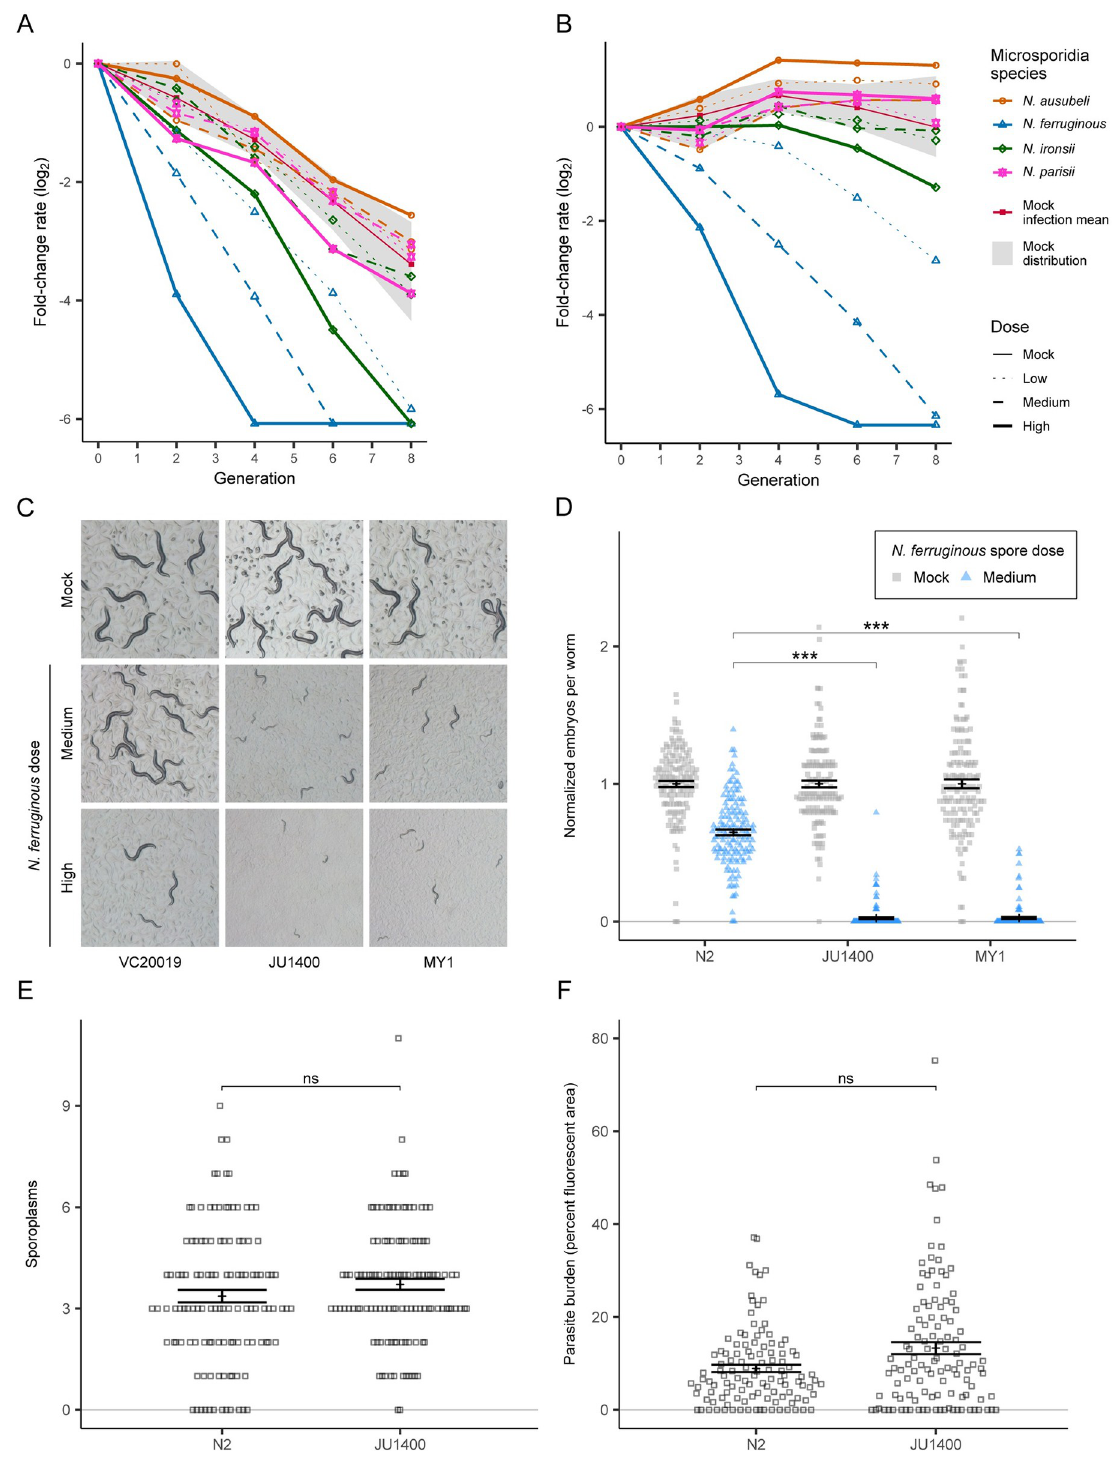
Fig 3. JU1400 lacks tolerance to N . ferruginous infection. (A-B) Line graph of fold change across multiple time points and conditions for JU1400 (A) and MY1 (B). Microsporidia strains are denoted by point shape and doses of microsporidia are denoted by line type. The eight uninfected control replicates are bounded within the greyed area and the mean of the uninfected control is denoted by a solid red line. All other lines represent mean FCR of two biological replicate samples. (C-D) Strains were infected for 72 hours with N . ferruginous . (C) Dissecting microscope images of live animals growing on plates. (D) Dot plot of normalized embryo counts of animals fixed and stained